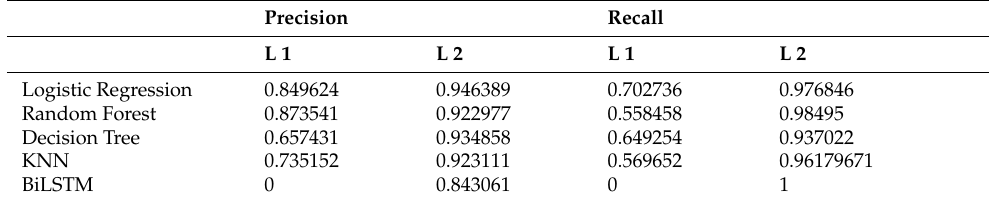
Table 4. Precision and recall for scenario 4 with the classification method (Y = “Sentiment”).